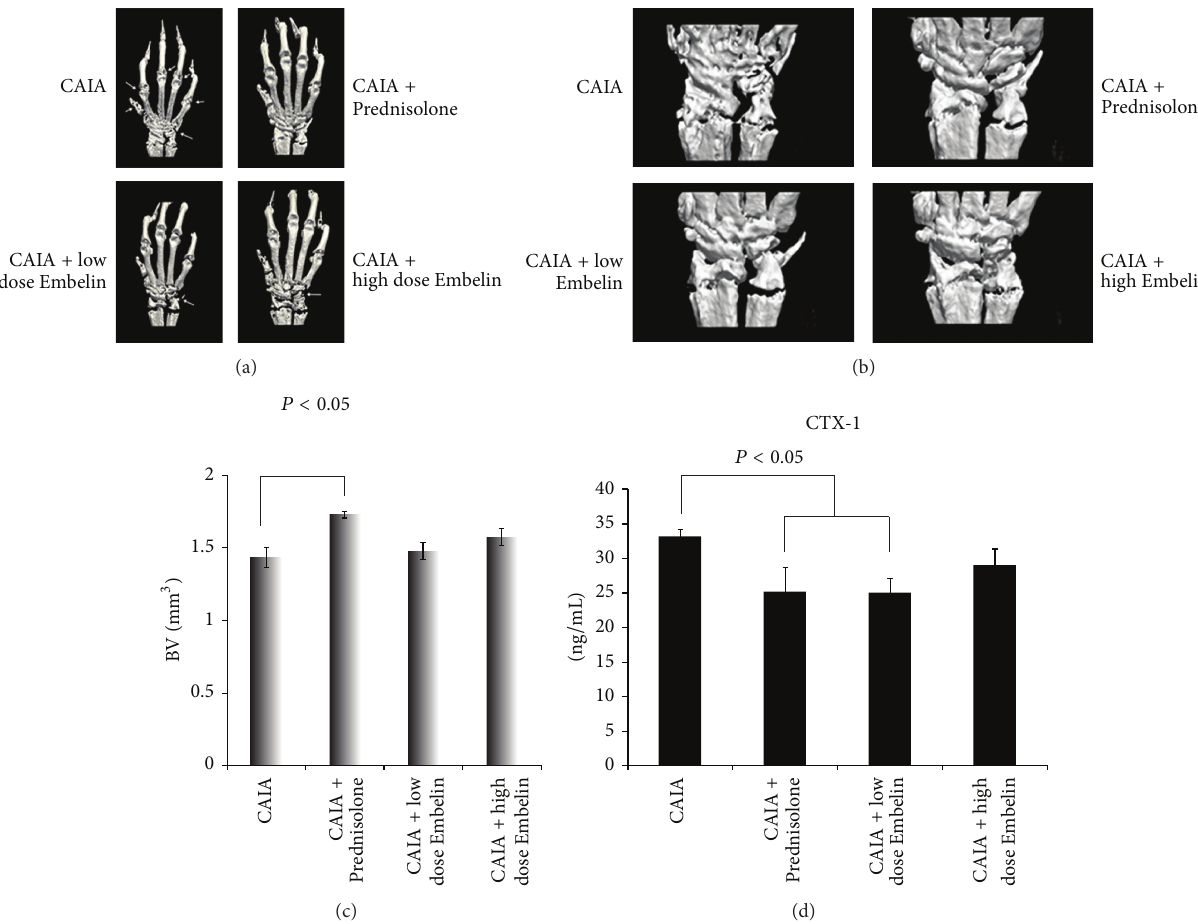
Figure 5: (a) Three-dimensional reconstruction of front right paw in each study group. Arrows point out bone area with erosion. (b) Three- dimensional reconstruction of the radiocarpal region from each mouse group chosen for quantitation of bone volume. (c) Mean bone volume (BV, expressed in mm 3 ) analysed by micro-CT in each group. (d) Mean serum CTX-1 level in each mouse group. Error bars represent standard error of the mean